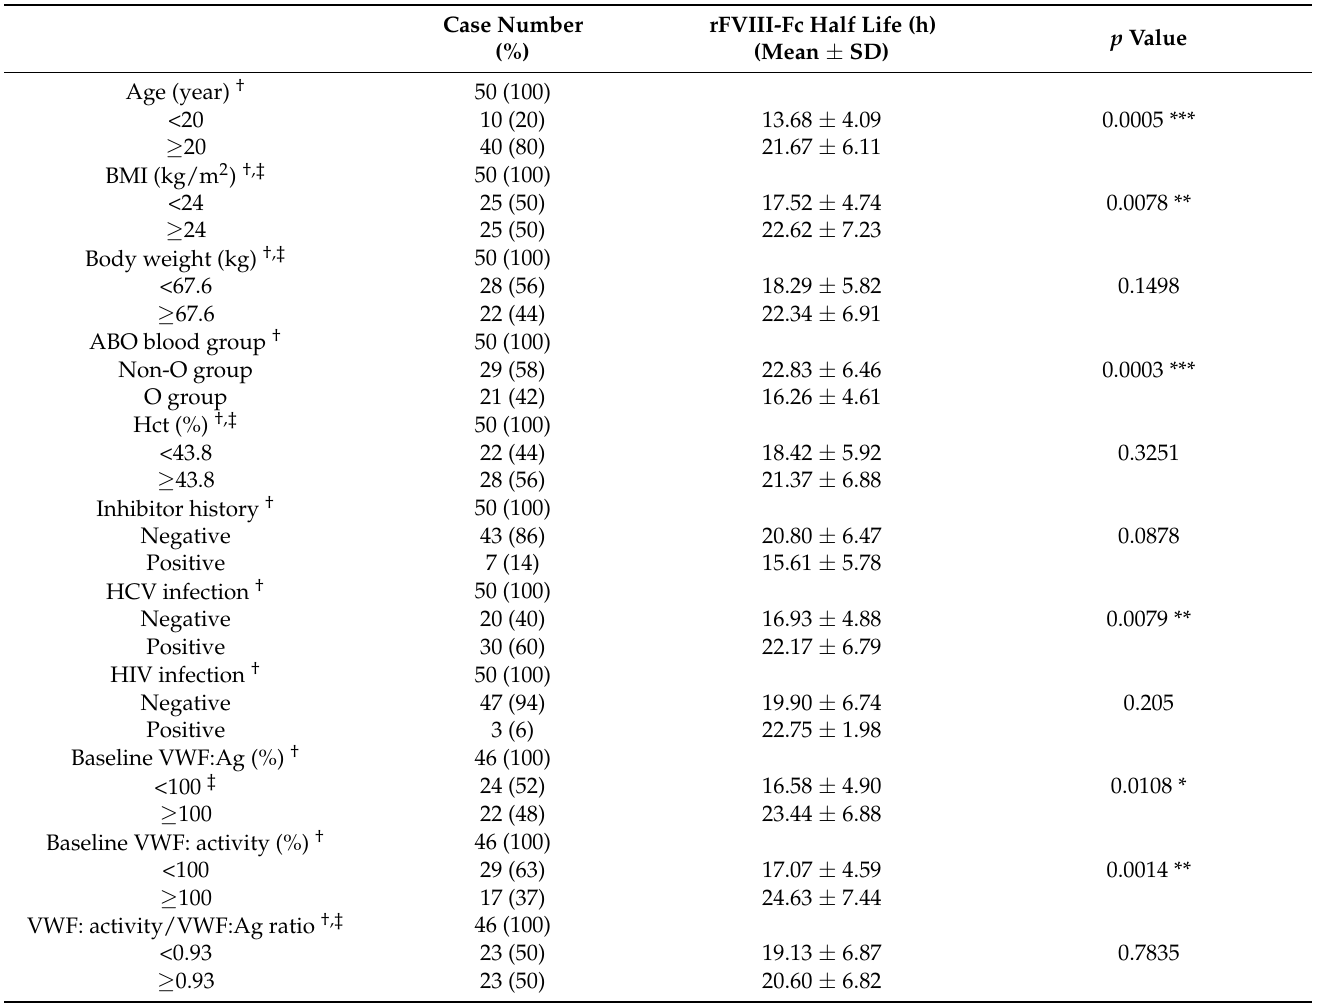
Table 2. Patient characteristics, clinical variables, and related tests for the rFVIII-Fc half lives in the development cohort of PwHA. Case Number rFVIII-Fc Half Life (h) (%) (Mean ±